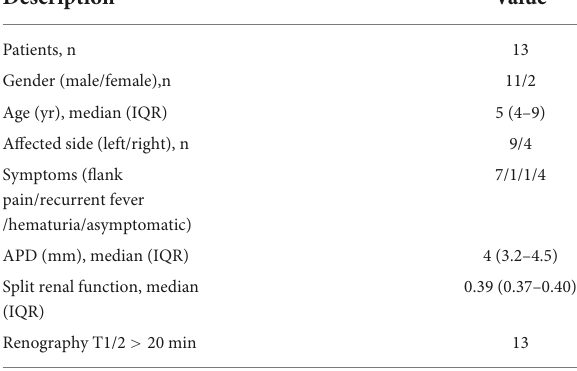
TABLE 1 Demographic and clinical data of the patients.